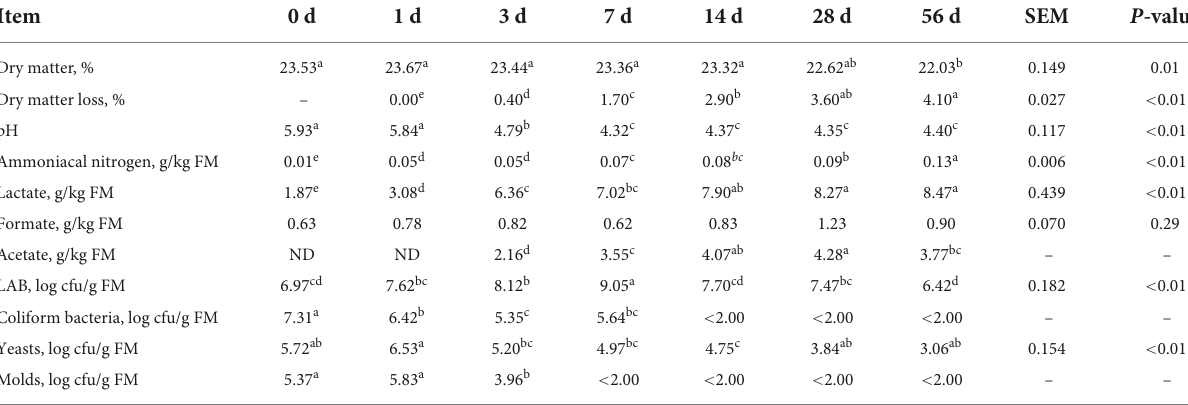
TABLE 1 Dynamic changes of dry matter, pH, organic acids, microbial counts and dry matter loss of sorghum stalk silage during ensiling process. Item